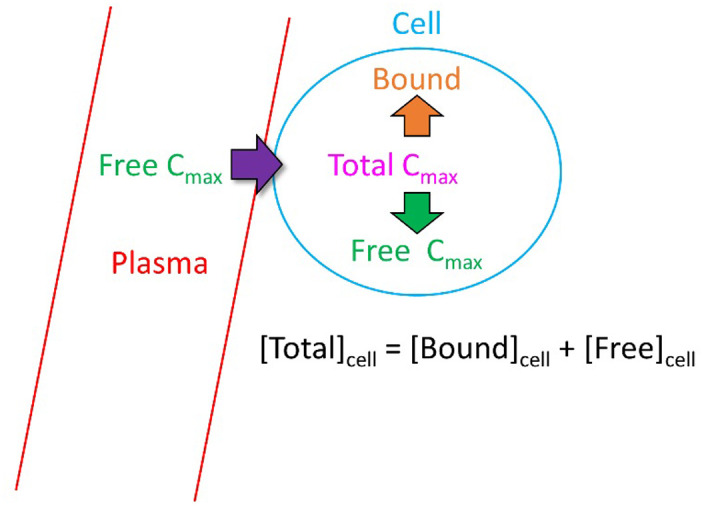
TFPCmax equates to TTICmax, such that the Hill equation, which is based on free concentration, cannot be solved (see text).